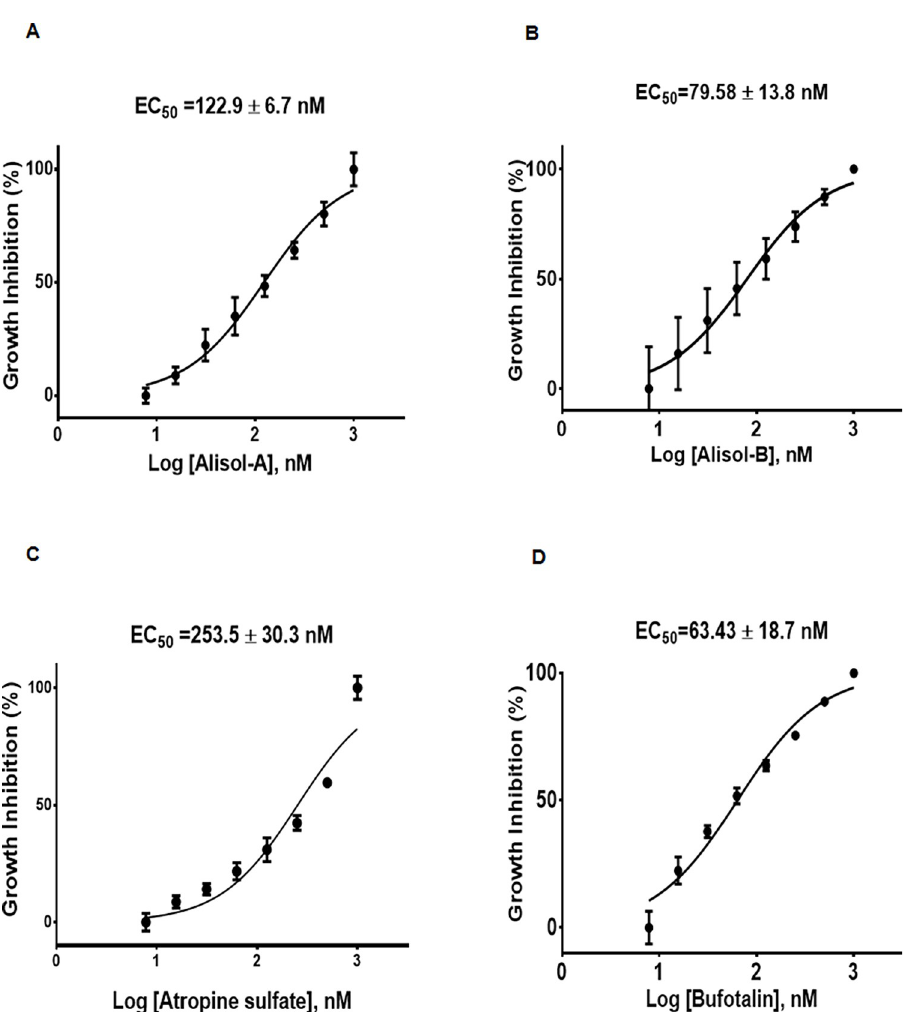
Fig 3. Dose-response curves and growth inhibitory effects of four hit compounds on C . parvum . The growth of C . parvum HNJ-1 strain after exposure to various concentrations of four hit compounds for 45 h, as determined by means of fluorescence microscopy. The EC 50 s were determined from dose response curves using non-linear regression (curve fit analyses). The values from triplicate experiments are shown. (A) Dose-response curves and the half maximum inhibition concentration (EC 50 ) value of alisol-A for C . parvum (122.9 ± 6.7 nM), (B) Dose-response curves and the (EC 50 ) value of alisol-B (79.58 ± 13.8 nM), (C) Dose-response curves and the (EC 50 ) value of atropine sulfate (253.5 ± 30.3 nM), (D) Dose-response curves and the (EC 50 ) value of bufotalin (63.43 ± 18.7 nM). showed a positive reaction and were clearly distinct from those observed in the HE (Fig 5F, 5I, 5L and 5O). For the nitazoxanide-treated groups, a number of attached C . parvum oocysts were also observed in the ileum (Fig 5G–5I; Score: 2+). In the atropine-sulfate-treated groups, C . parvum infection led to a smaller number of oocysts being attached to the intestinal villi than in the positive control group (Fig 5J–5L; Score: 2+). Bufotalin-treated mice showed a sig- nificant reduction in the number of oocysts compared to the positive control group (Fig 5M– 5O; Score: 1+). These results indicate that bufotalin is the most effective of the compounds tested in terms of anti- Cryptosporidium activity in vivo . Some histological findings (karyome- galy, hepatocellular hypertrophy, or interstitial inflammation) were observed in all examined livers (S3 Fig), it suspected sub-effect of compounds or infection, but there was no difference in distribution and severity between experimental groups.